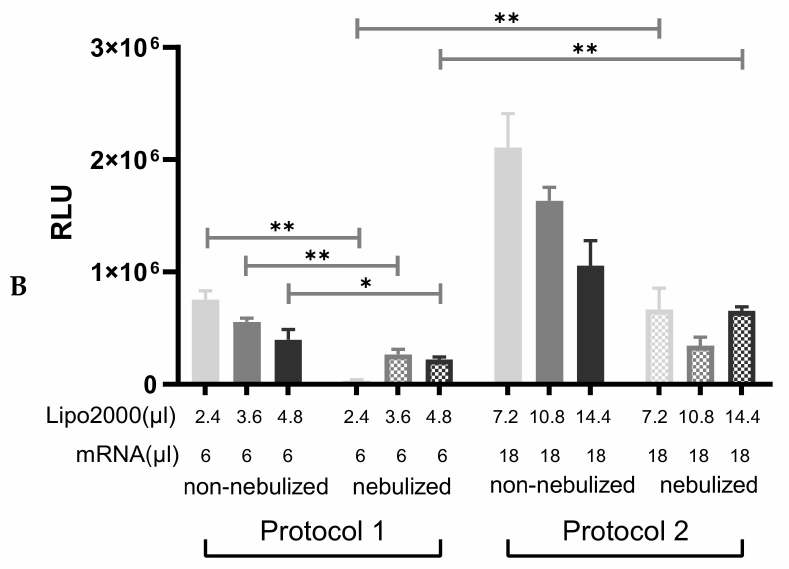
Figure 6. Transfection efficiency of MetLuc-mRNA/Lipofectamine2000 complexes before and after nebulization via different nebulization protocols. Lipoplexes were prepared in OptiMEM ( A ) or Ham’s F-12K medium ( B ). For protocol 1, 2.4 µ L, 3.6 µ L and 4.8 µ L Lipofectamine2000 was mixed with 6 µ L MetLuc-mRNA (0.1 µ g/ µ L). After 10 min, the samples were diluted in 3.0 mL medium. For protocol 2, complexes were prepared with 7.2 µ L, 10.8 µ L and 14.4 µ L Lipofectamine2000 mixed with 18 µ L MetLuc-mRNA (0.1 µ g/ µ L). “Lipo2000” represents Lipofectamine2000 and “mRNA” represents MetLuc-mRNA. After 10 min, the samples were diluted in 3.0 mL medium. For both protocols, a fraction of the complexes was kept separately and used as a “non-nebulized” control (solid bars). The rest of the solution was aerosolized for 5 min using a PARI Boy ® jet-nebulizer and the collected part was used as “nebulized” formulation (dots filled bars). Both the non-nebulized control complexes and the nebulized complexes were used to transfect 16HBE cells for 2 h. The transfection efficiency was measured 24 h after transfection. The results are presented as relative light units (RLU), n = 5. Significance was determined by a two-tailed unpaired Student’s t -test (* p < 0.05 and ** p <